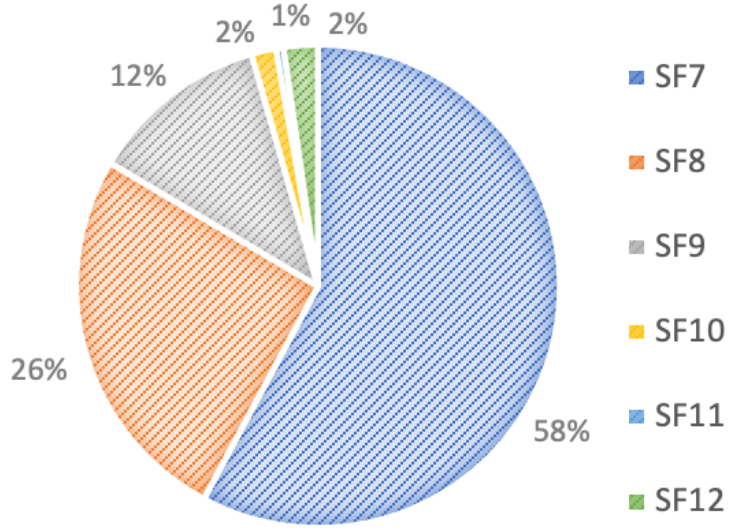
Figure 9. Received traffic for SFs over 25 km² without water leakage.